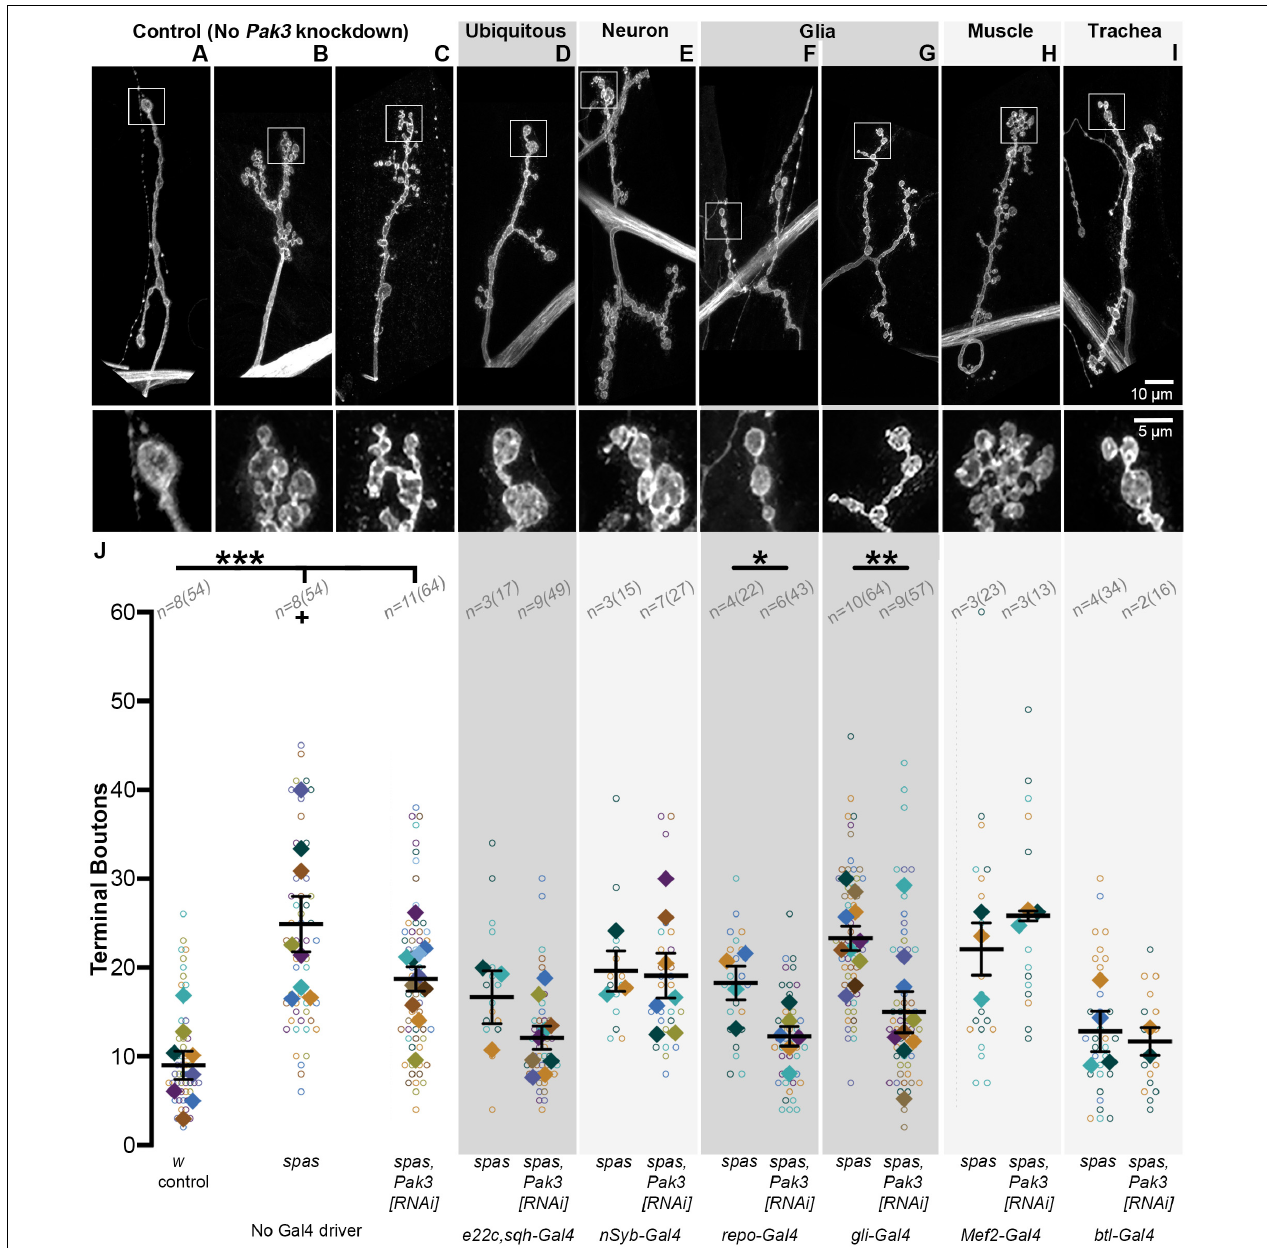
FIGURE 2 | Glial, and specifically subperineurial glial, knockdown of Pak3 rescues spastin synaptic defects. (A–I) Anti-HRP staining shows neuronal morphology at the NMJ. The area within the box is magnified below. (A–C) are genetic background controls in which Pak3 RNAi is not expressed via GAL4 activation ( A wild type; B,C : spastin 5 . 75 mutant); (D–I ) are representative arbors from spastin 5 . 75 mutants in which Pak3 RNAi is expressed in the specified tissues. (A) Wild type synaptic boutons are arrayed linearly with few branches, while (B) spastin 5 . 75 loss of function mutants have highly branched arbors with many small, bunched boutons. (C) In the absence of a GAL4 driver, the Pak3 RNAi transgene has little effect on spastin 5 . 75 morphology; terminal boutons remain significantly increased compared to wild type. (D) Ubiquitous expression of Pak3 RNAi in the spastin 5 . 75 background yields terminal boutons more similar in size, arrangement, and number to wild type. (E) Pak3 RNAi expression in neurons does not rescue the spastin mutant phenotype, but (F,G) Pak3 knockdown in all except midline glia with repo-GAL4 (F) , or in subperineurial glia with gliotactin-GAL4 (G) , significantly rescues spastin 5 . 75 . (H,I) Knockdown of Pak3 in muscle (H) or trachea (I) show no difference in morphology from their spastin 5 . 75 controls. (J) Synaptic morphologies are quantified by measuring the number of terminal boutons at each muscle 4 in a larva. In this and subsequent graphs, each open circle represents the quantity scored at an individual muscle; solid diamonds are the average of these counts for each larva, grouped by color; bars represent larval mean ± SEM; n(N) = number of larvae (number of muscles scored). “+” denotes two data points (y = 65 and 77) that fall outside of the y -axis range. The number of terminal boutons is statistically reduced compared to its driver-specific spastin 5 . 75 control only when Pak3 RNAi is expressed in glia or subperineurial glia. When compared to the spastin 5 . 75 control, Pak3 RNAi alleviates the spastin mutant phenotype if expressed ubiquitously, in all glia, or in subperineurial glia ( p = 0.02). Statistical significance is calculated by Student’s t -test; asterisks signify p ≤ 0.001 (***), 0.001 < p ≤ 0.01 (**), or 0.01 < p ≤ 0.05 (*).